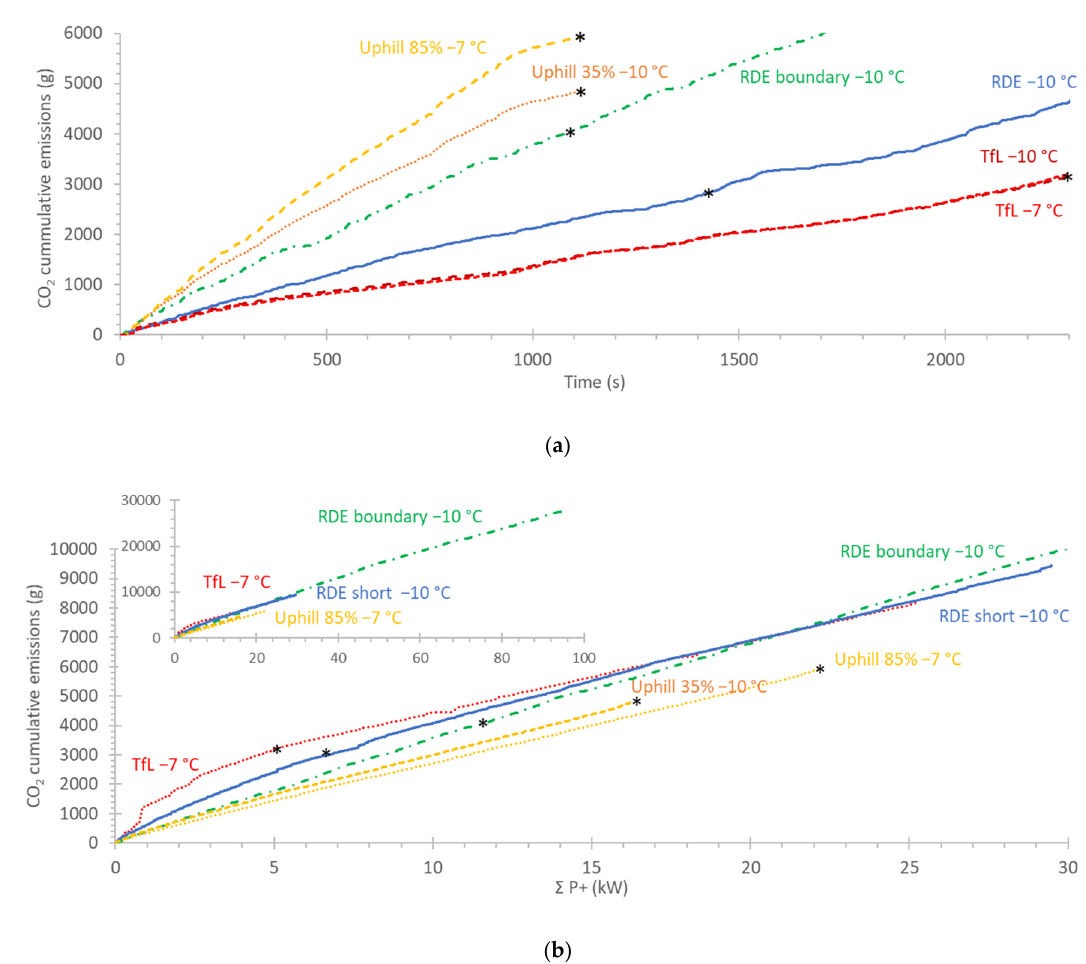
Figure 2. Various cycles at − 7 °C and − 10 °C. Asterisk indicates the point at which a distance of approximately 9 km is covered ( a ) in function of time and ( b ) in function of cumulative positive power.